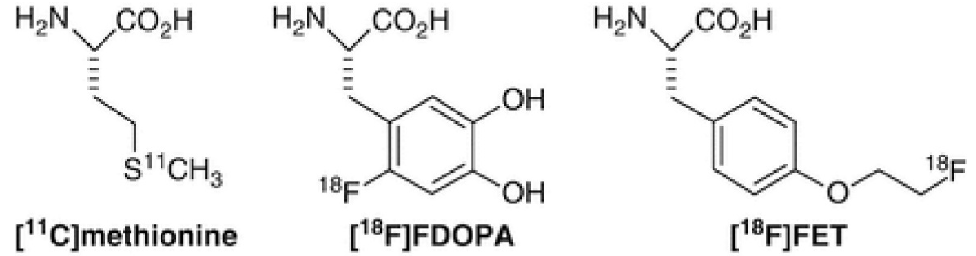
Figure 2. Chemical structures of 11 C-methionine, 18 F-DOPA and 18 F-FET.